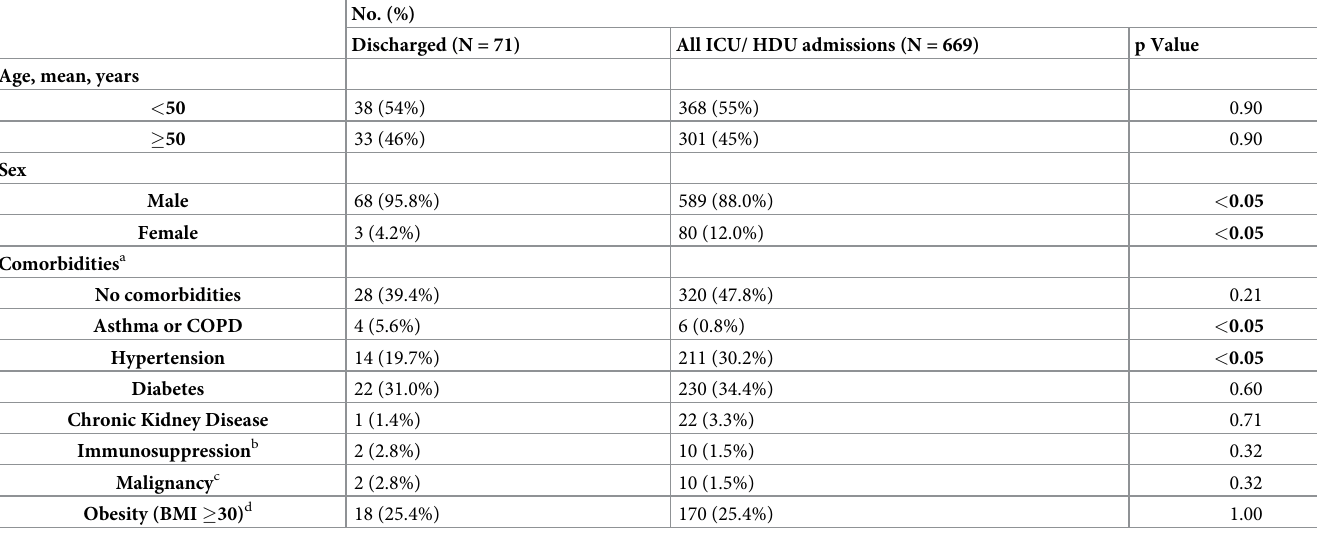
Table 2. Demographics of patients transferred from critical care units to general medical ward and all COVID-19 critical care patients.